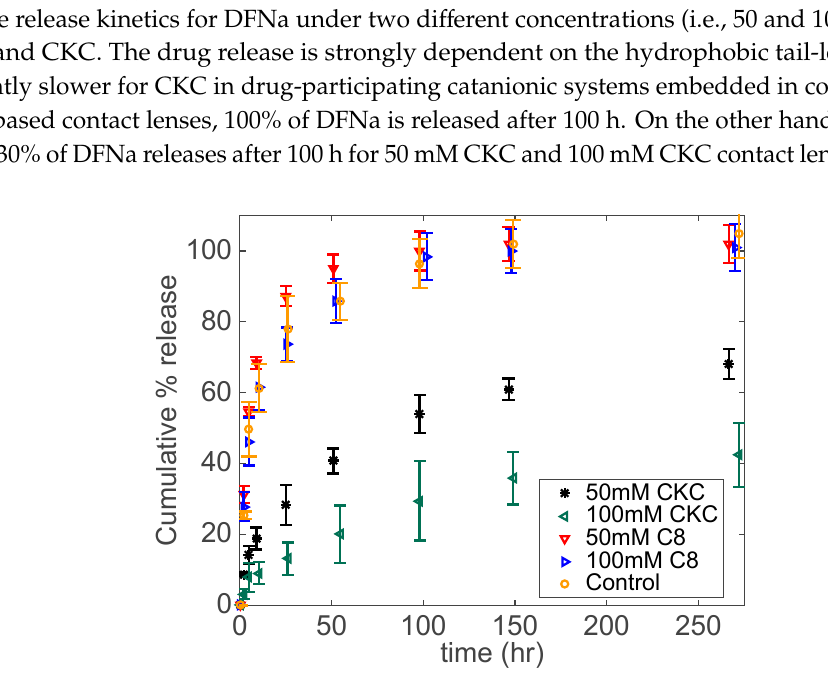
Figure 4. DFNa cumulative % release as a function of time under two different concentrations of CKC or C8. Catanionic aggregates were prepared at a fixed concentration of DFNa (30 mM) and Brij 97 (20 wt%). Total amount of drug per lens: 102.6 ± 9.2 µg for 50mM C8; 94.7 ± 7.6 µg for 100 mM C8; 120.0 ± 12.4 µg for 50 mM CKC; 134.3 ± 18.5 µg for 100 mM CKC. Data are presented as mean ± standard deviation with n = 3.